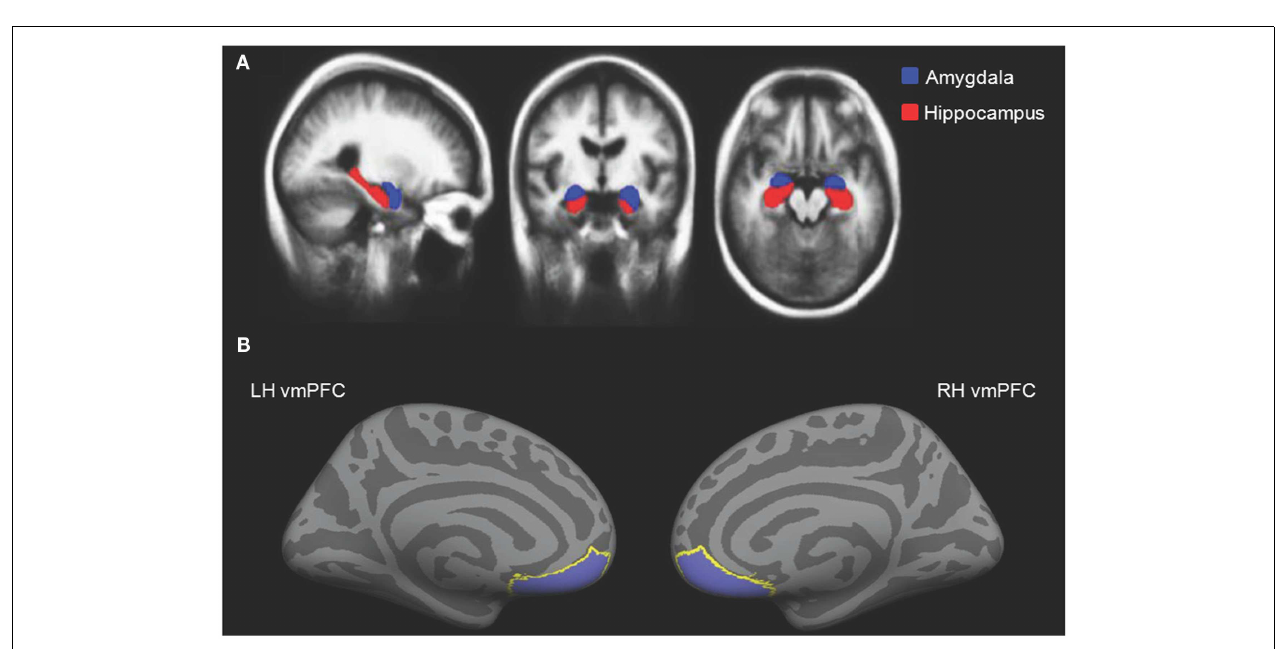
FIGURE 2 | (A) Independently defined anatomical volumetric ROIs of bilateral amygdala and hippocampus and (B) independently defined anatomical surface-based ROIs of bilateral vmPFC.